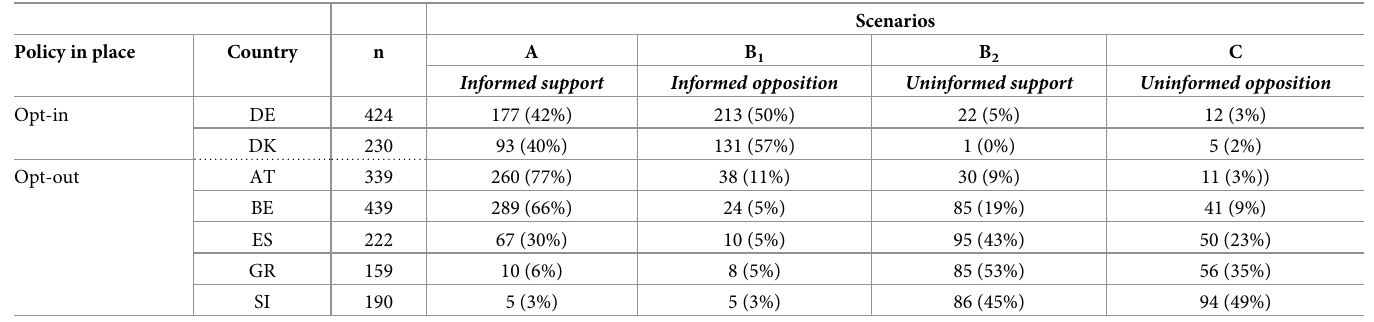
Table 5. Health governance indicator I: Policy capacity to represent the preferences of an informed